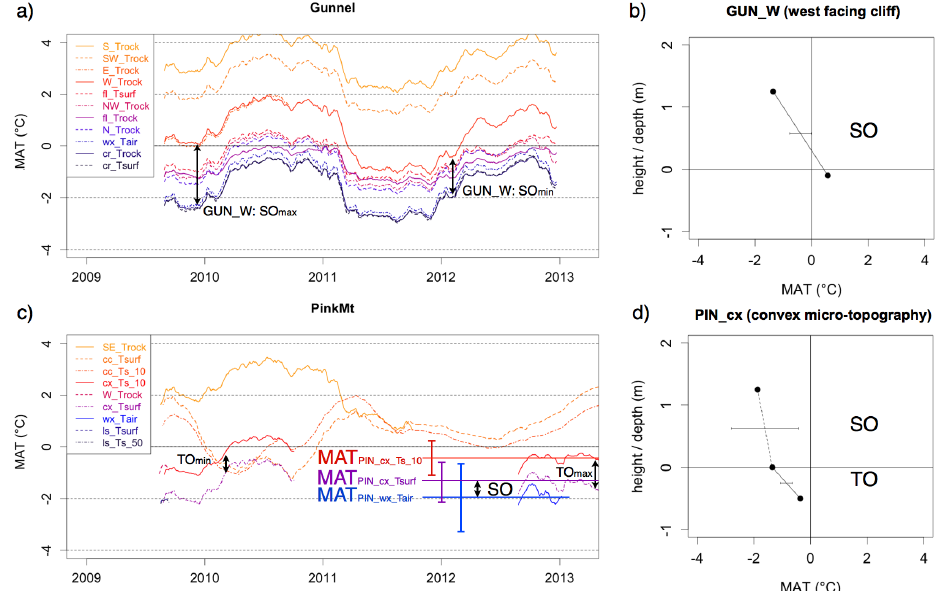
Figure 2. The running mean annual temperatures (running MAT) at two field sites and two profile plots of the MAT. (a) Mount Gunnel: all near-surface MAT from vertical rock faces have a development parallel to the mean annual air temperature (MAAT); indications of maximum and minimum surface offset are explained in text. (b) Example of the surface offset (SO) shown in the MAT profile of a west-facing cliff at Mount Gunnel; the temperature at 1.4m height is the MAAT. (c) Pink Mountain; the MAT from convex (cx) and concave (cc) landforms show inverse development. Offsets strongly depend on the point in time of the comparison of instantaneous MATs. This example is a worst case in terms of data completeness. (d) MAT profile with spreads indicating the uncertainties of the surface and thermal offsets at Pink Mountain. The solid lines indicates an offset that is larger than the spread (TO), and the dashed line is used when offset is equal or smaller than the spread